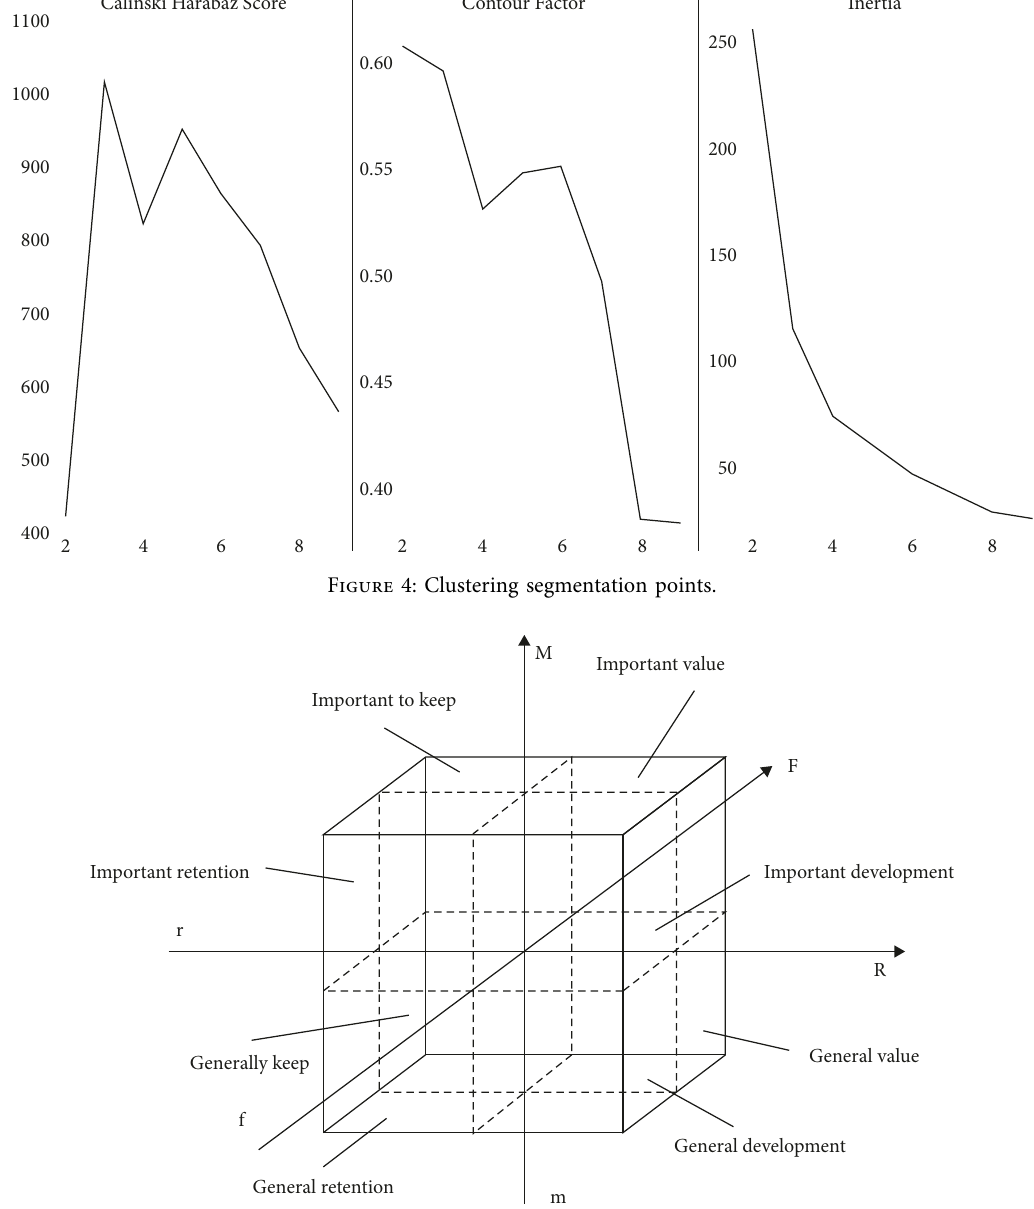
Figure 5: Classification of improved RFM 3D